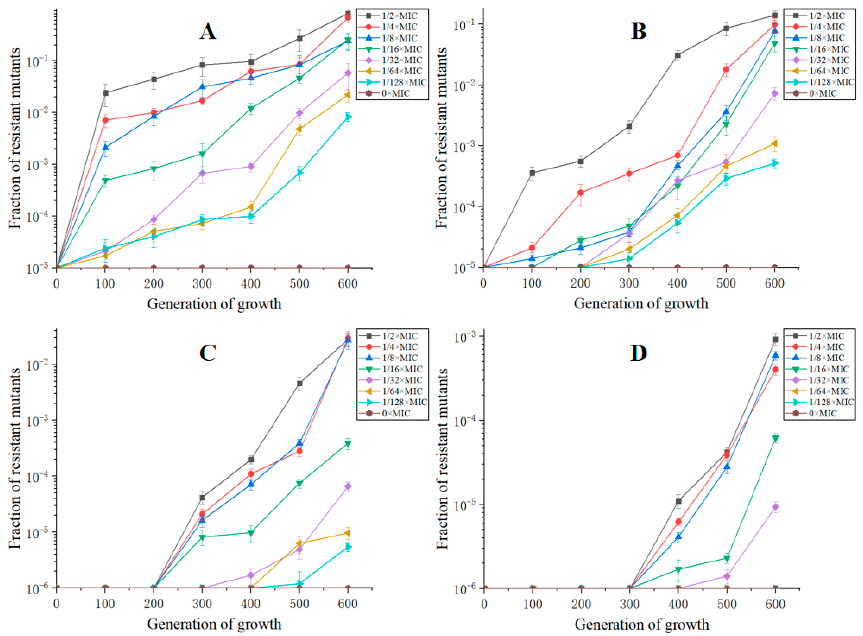
Figure 1. Resistance rates of S. Enteritidis CICC21527 exposed to sub-MICs of ENR at resistance level of 2×MIC ( A ), 4×MIC ( B ), 8×MIC ( C ) and 16×MIC ( D ). 2.2. Mutations in the QRDRs of the Mutants with Reduced Susceptibility to ENR Compared to the parental strain, 12 out of 16 strains exhibiting MICs of 2 to 16×MIC had a mutation in the QRDR of the gyrA gene (Table 1). Among them, the mutation of Ser83Tyr was the most frequent ( n = 6), followed by the mutations of Ser83Phe ( n = 5) and Asp87Gly ( n = 2). It was also demonstrated that mutation in gyrA was not found in all reduced susceptibility mutants ( ≤ 8×MIC), while mutation was presented in all resistant mutants ( ≥ 16×MIC). No mutations in the QRDRs of gyrB , parC and parE were observed. Table 1. Mutation sites in the QRDRs of gyrA , gyrB , parC , and parE genes of S. Enteritidis mutants. Substitutions in QRDR Amino Acid Residues Strain Number MIC ( μ g/mL) gyrA gyrB